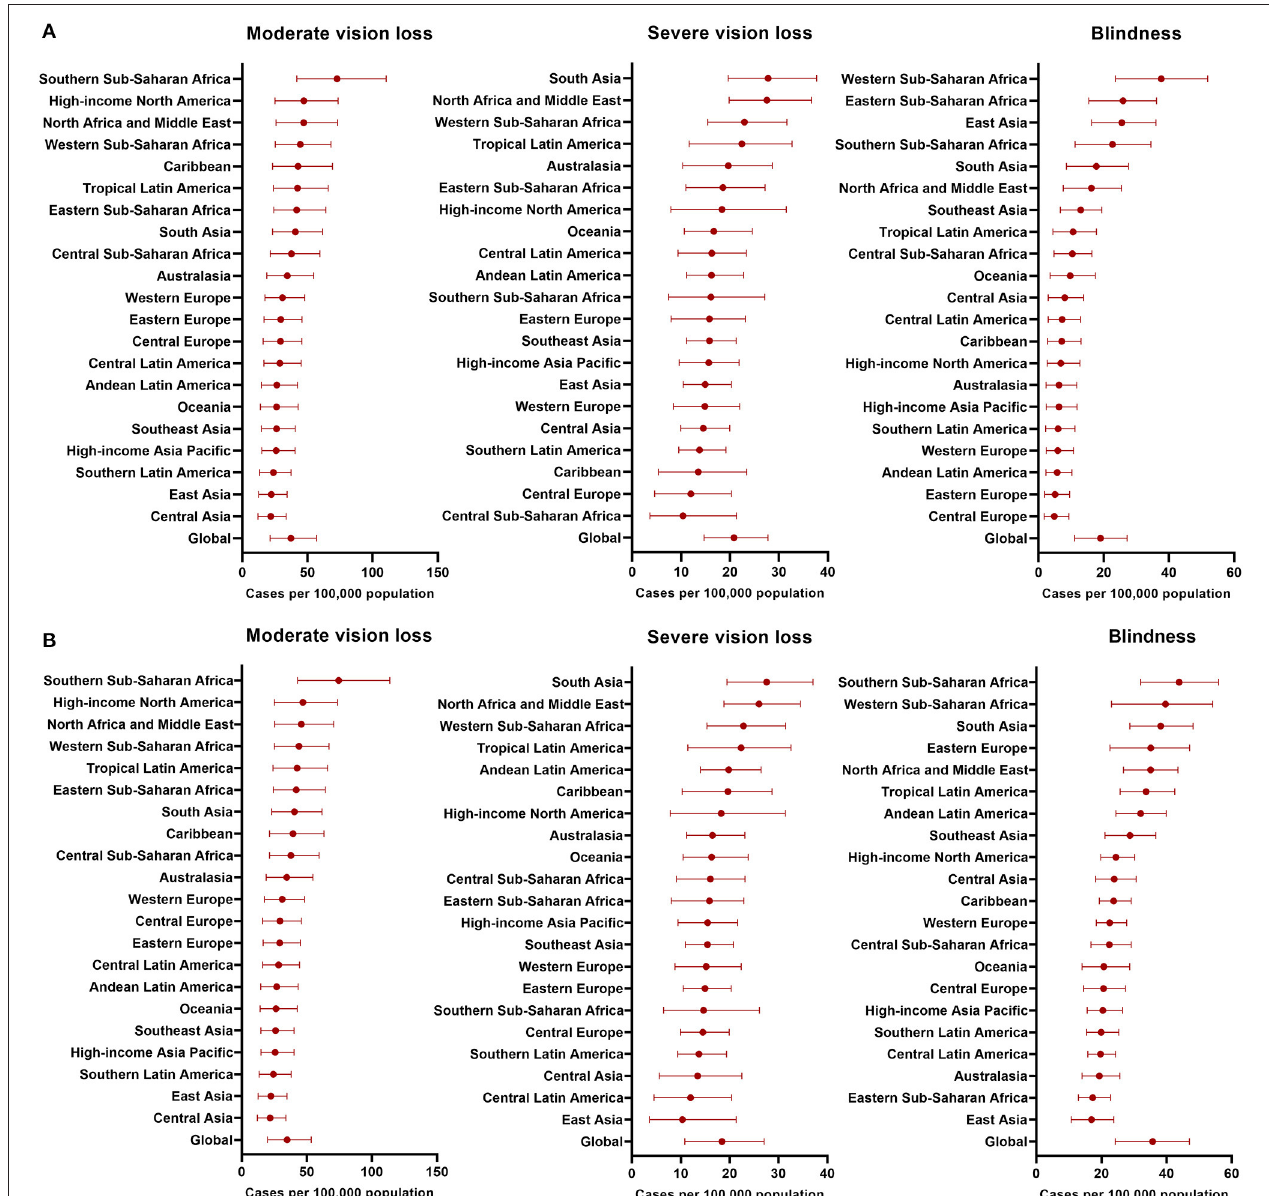
FIGURE 3 | Incidence and Prevalence of ROP-related blinding varies among 21 GBD regions. (A) Incidence of ROP in 2019; (B) Prevalence of ROP in